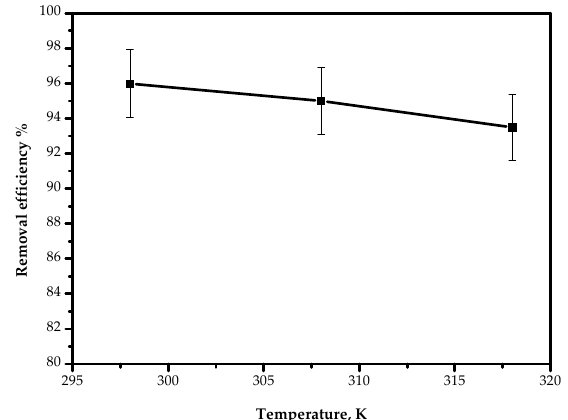
Figure 11. Effect of the temperature on the removal of Pb(II) ions by AILP.